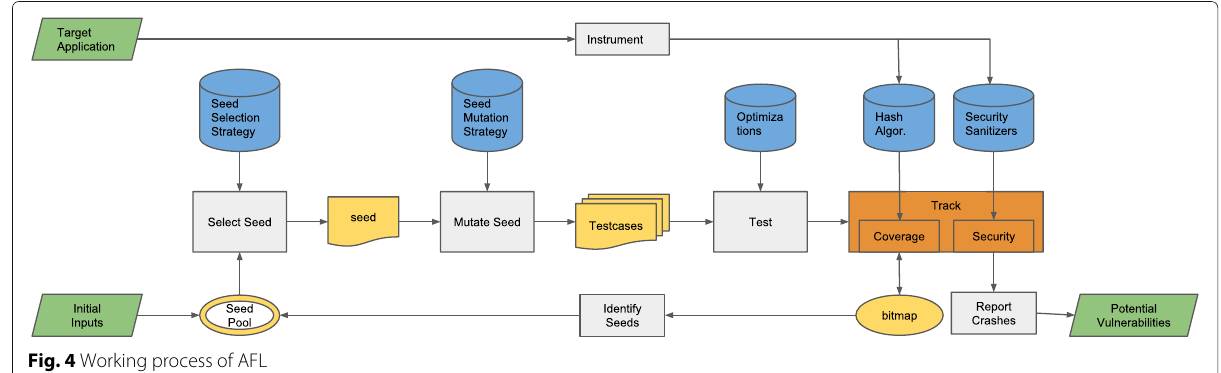
Fig. 4 Working process of AFL